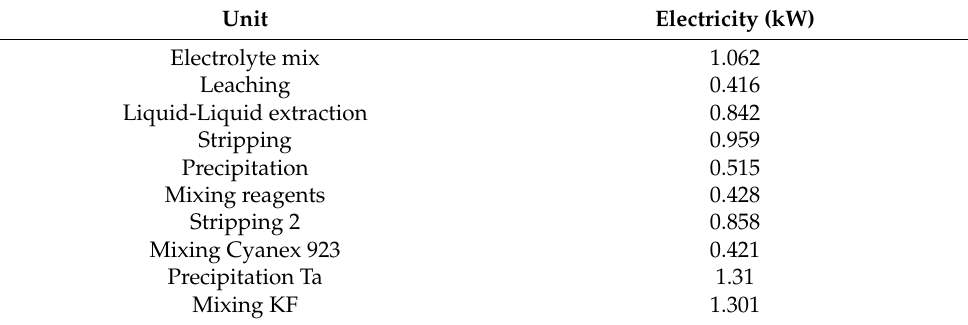
Table 3. Electricity needed on each